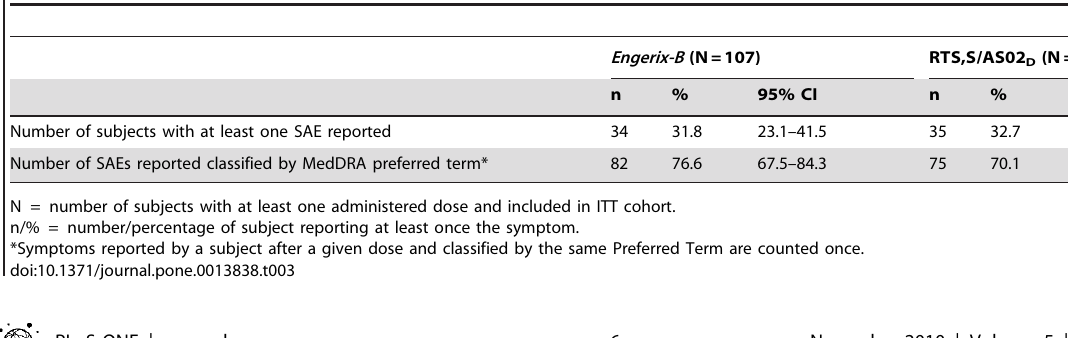
Table 3. Percentage of participants reporting SAEs classified by MedDRA primary organ class and preferred term over 14 months